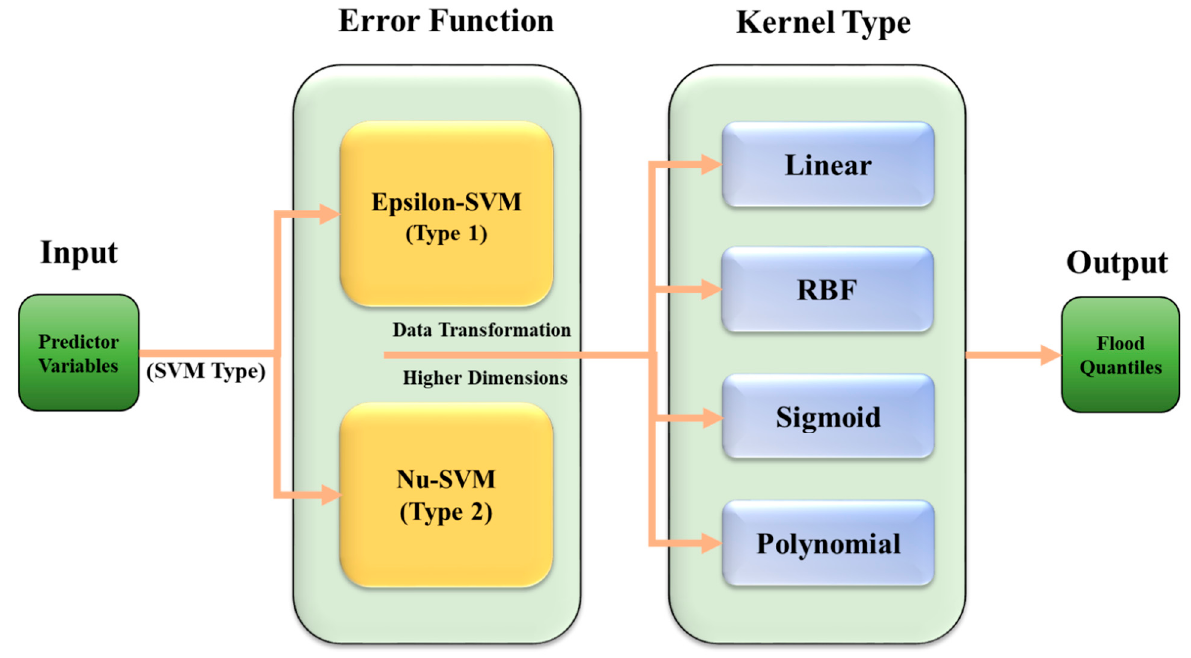
Figure 5. SVM structure. Figure 5. SVM 3. Statistical Metrices Used for Model Evaluation